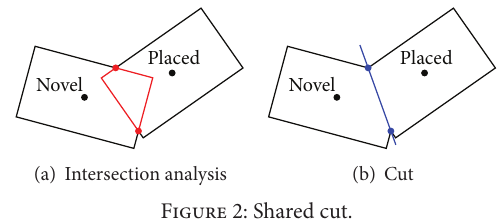
Figure 2: Shared